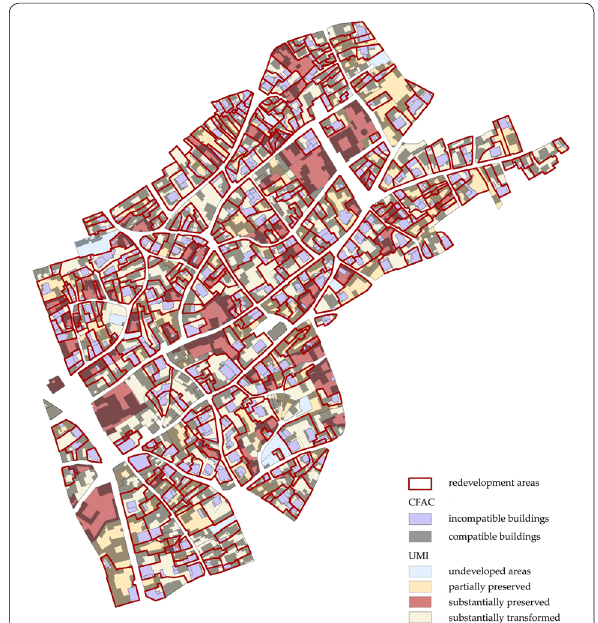
Fig. 2 Identification of the UMIs by judgement of historical landscape value and those to be redeveloped. Detailed Urban Plan Data processed on GIS software